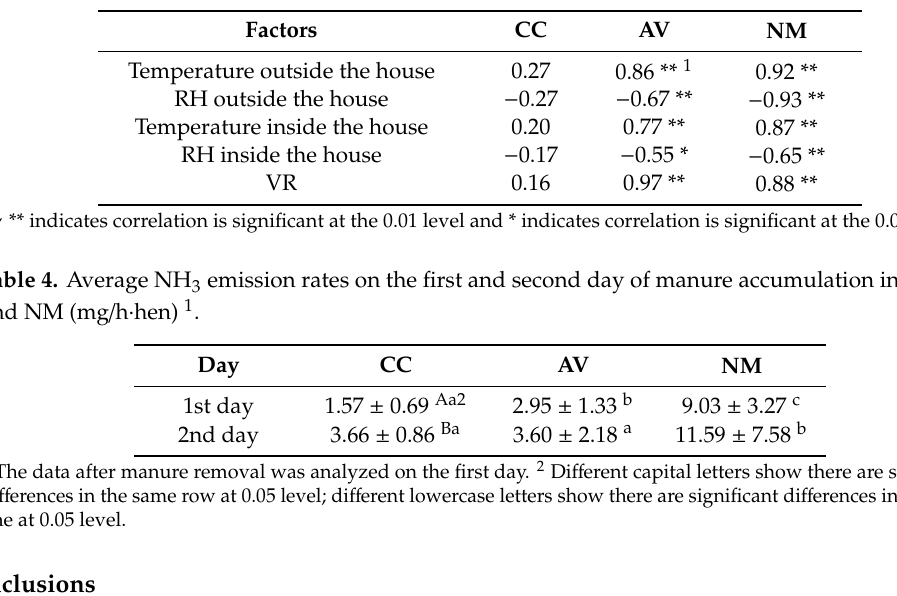
Table 3. Correlations between NH 3 emission rates and environmental factors.